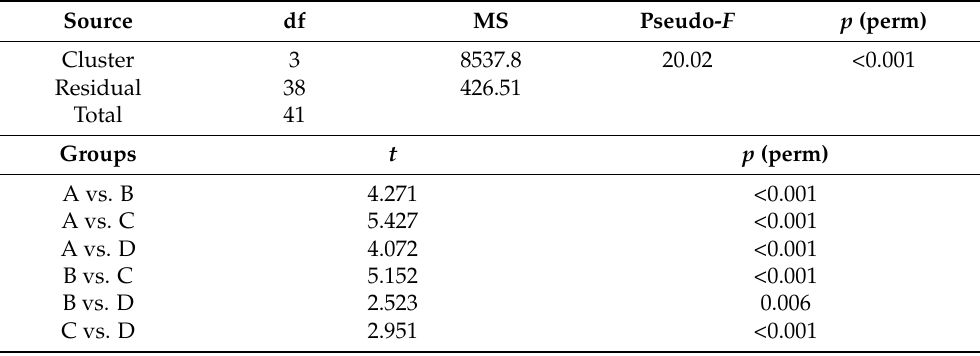
Table 1. Results of PERMANOVA and pairwise tests on phytoplankton community composition of